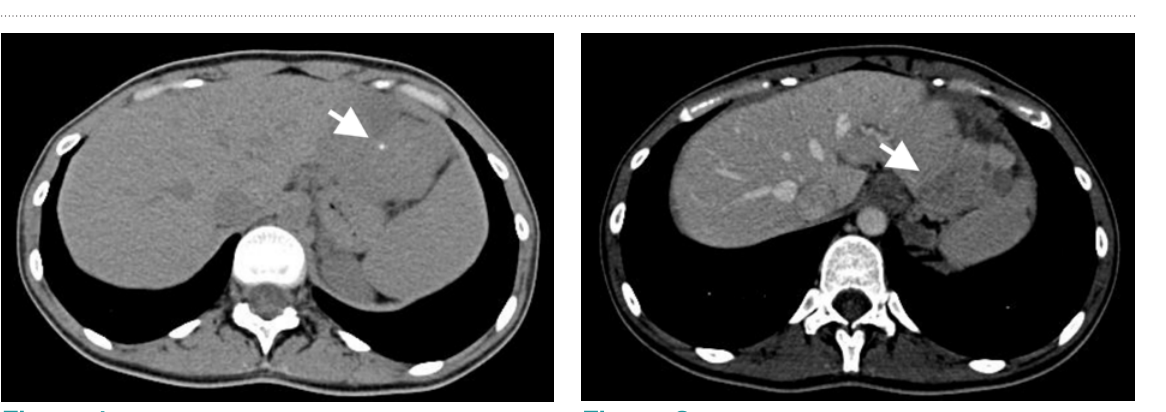
Figure 1. Nonenhanced CT scan demonstrates the presence of a hypodense mass with calcification within the central scar over the left hepatic lobe.